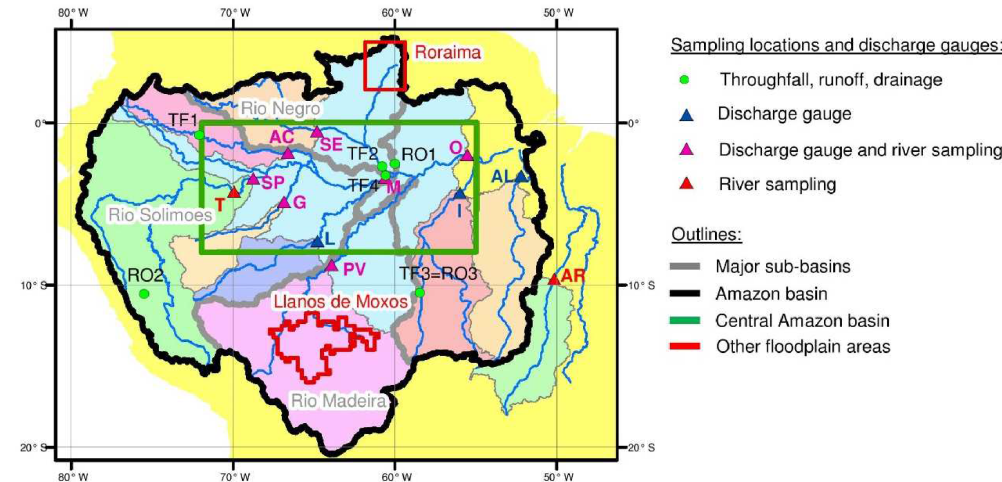
Figure 4. Overview of the Amazon basin, with highlighted boundaries (thick grey) between the three major sub-basins (R. Solimoes, Madeira and Negro). The central Amazon basin (green box) and the sampling locations discussed in this study are also shown. River sampling locations and discharge gauges include Rio Japura at Acanaui (AC), Rio Xingu at Altamira (AL), Rio Araguaia (AR), Rio Jurua at Gaviao (G), Rio Tapajos at Itaituba (I), Rio Purus at Labrea (L), Rio Solimoes at Manacapuru (M), Amazon River at Obidos (O), Rio Madeira at Porto Velho (PV), Rio Negro at Serrinha (SE), Rio Solimoes at Sao Paulo de Olivenca (SP) and Tabatinga (T). The contributing areas are shown by the different colour codes on the map, except for location T as it is very similar to location SP. The remaining ungauged terrestrial area is represented in yellow. Sampling locations for throughfall DOC are indicated by “TF” and report data from Tobon et al. (2004) (TF1), Filoso et al. (1999) (TF2), Johnson et al. (2006) (TF3) and Williams et al. (1997) (TF4). Sampling location for DOC concentration in surface runoff and/or head waters are indicated by “RO” and report data from Waterloo et al. (2006) (RO1), Saunders et al. (2006) (RO2) and Johnson et al. (2006) (RO3). The red box and red line represent large floodplain areas outside the central Amazon basin for which observations are available.